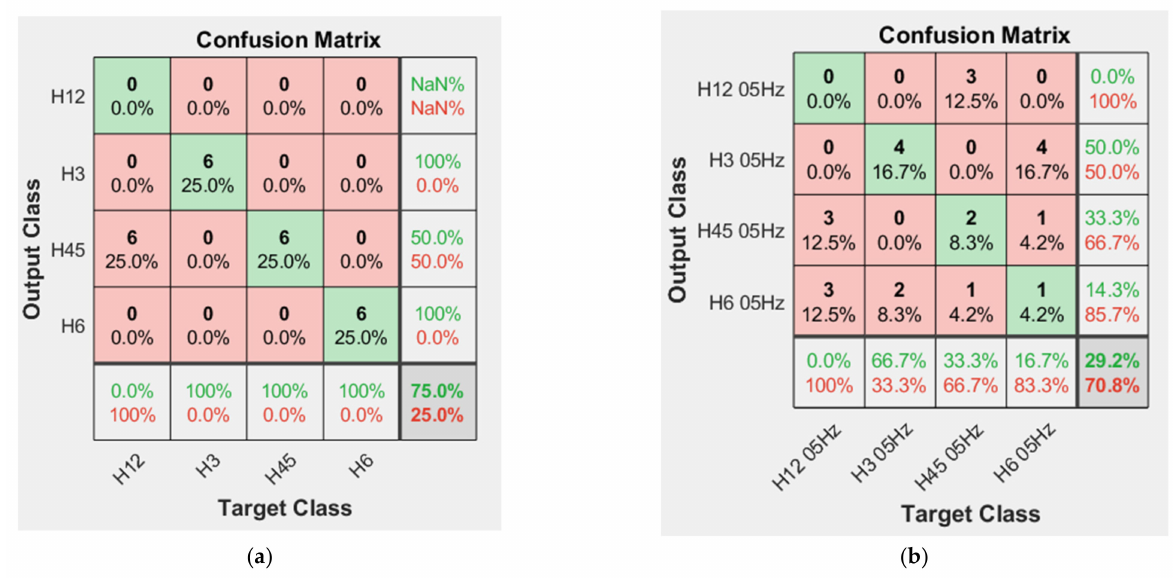
Figure 15. Confusion matrices (test set) obtained with decimated data: ( a ) single fault and ( b ) double fault.